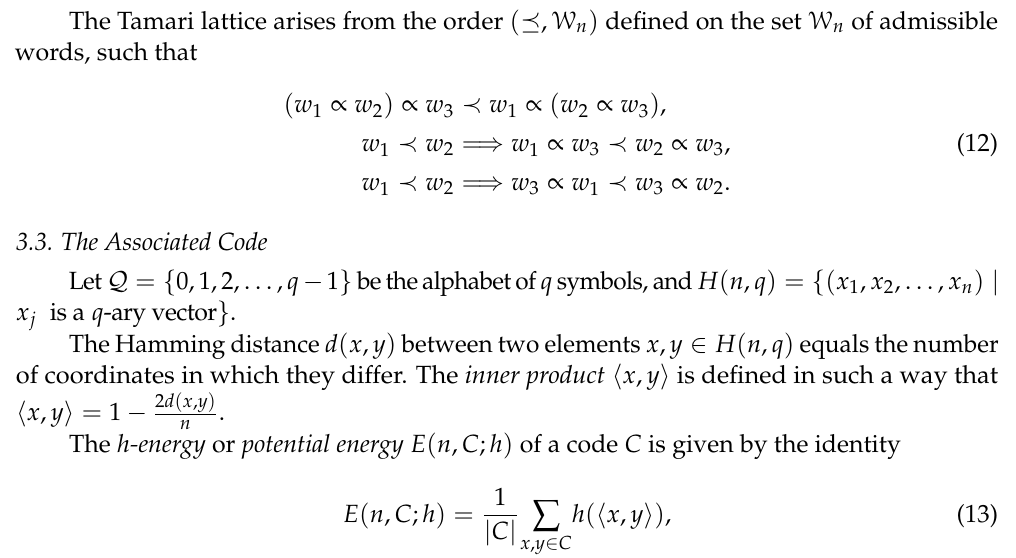
Figure 7. The grove consisting of binary trees associated with three-tile snake